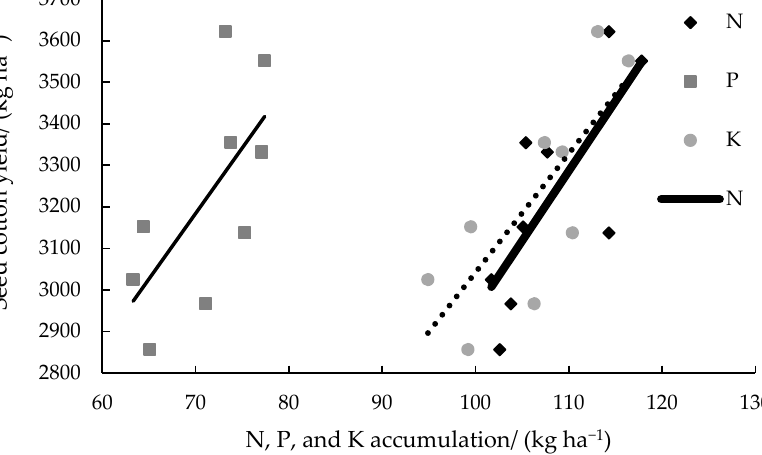
Figure 1. Correlation between seed cotton yield and the total accumulations of N, P, and K during whole growing period. Note: N: y = 33.661x − 416.145 (R 2 = 0.757; p = 0.018); P: y = 31.536x + 976.843 (R 2 = 0.669; p = 0.049); and K: y = 28.603x + 181.991 (R 2 = 0.775; p = 0.014).